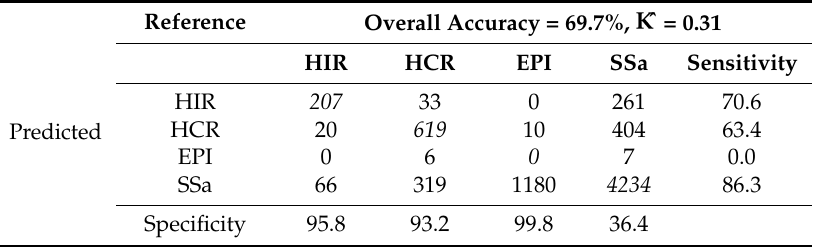
Table 5. Error matrix for BC3. Class codes as follows: High-energy infralittoral rock (HIR); High-energy open-coast circalittoral rock (HCR); Non-reef sediment epibenthos (EPI); Sublittoral sand and muddy sand (SSa). Italicized values indicate correctly classified